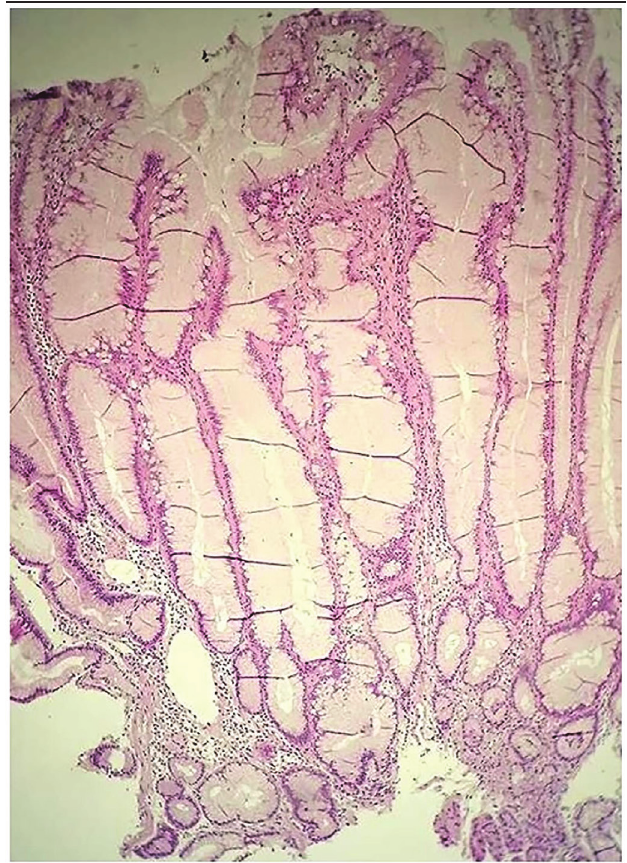
figurE 2 − Body of the stomach affected by Ménétriér disease; hyperplasia of the gastric foveolar epithelium with mononuclear inflammatory infiltrates in the lamina propria and atrophy of oxyntic